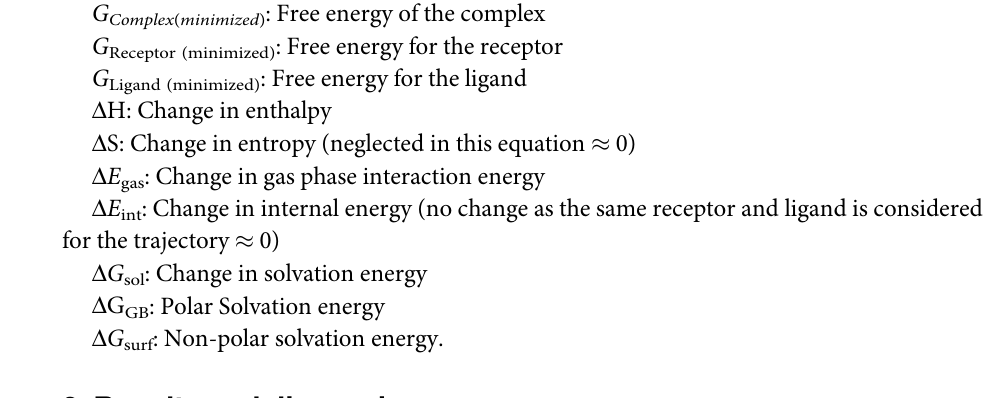
PLOS ONE | https://doi.org/10.1371/journal.pone.0277328 November16,